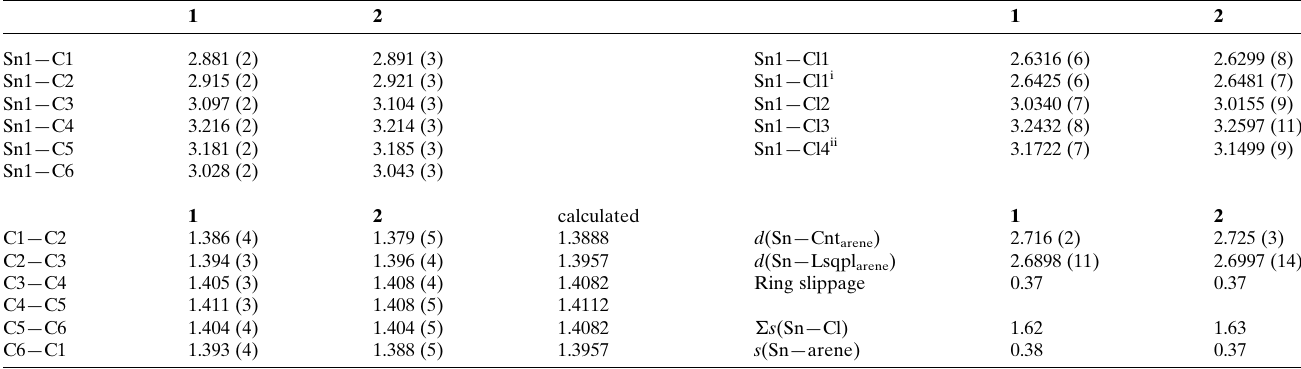
Table 1 Selected bond lengths and contact distances (A˚ ) in 1 and 2 and corresponding ring slippage values and bond valences, calculated using the Brown formalism (Brown, 2009) with r 0 = 2.42 and B = 0.39 (Frank, 1990 a ). Cnt arene = arene centre; Lsqpl arene = arene plane..